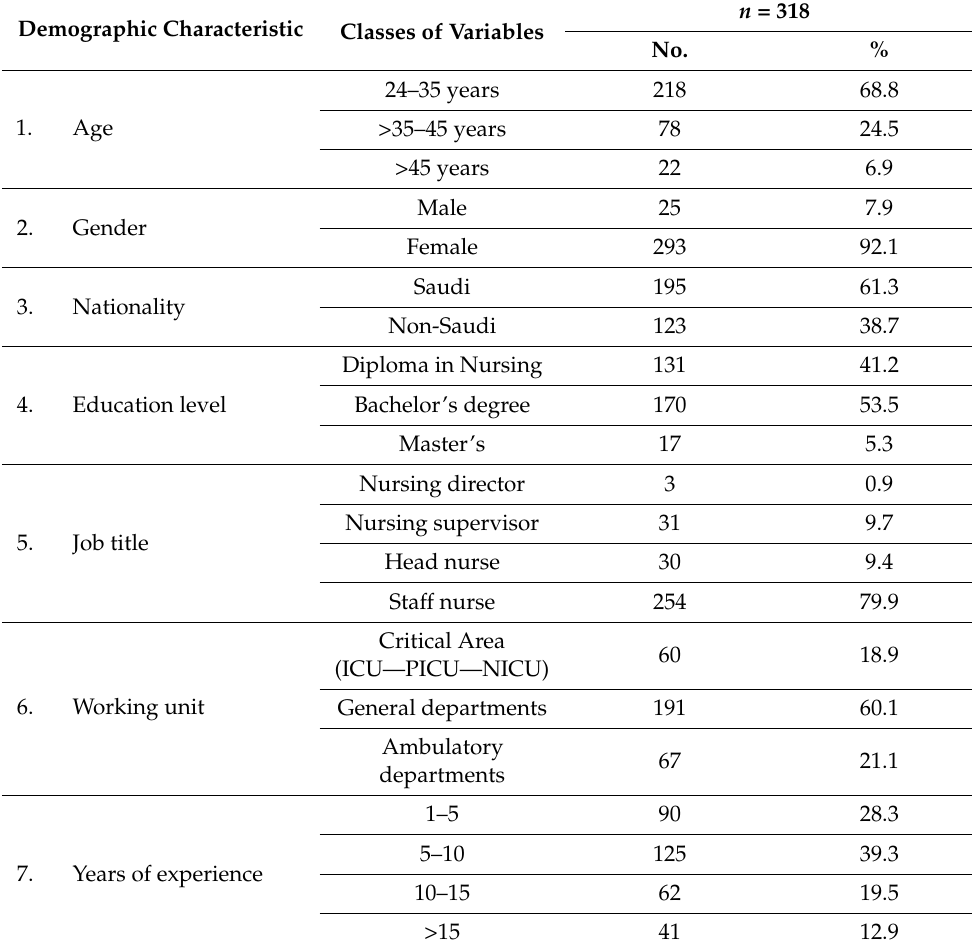
Table 1. Nurses’ demographic characteristics.